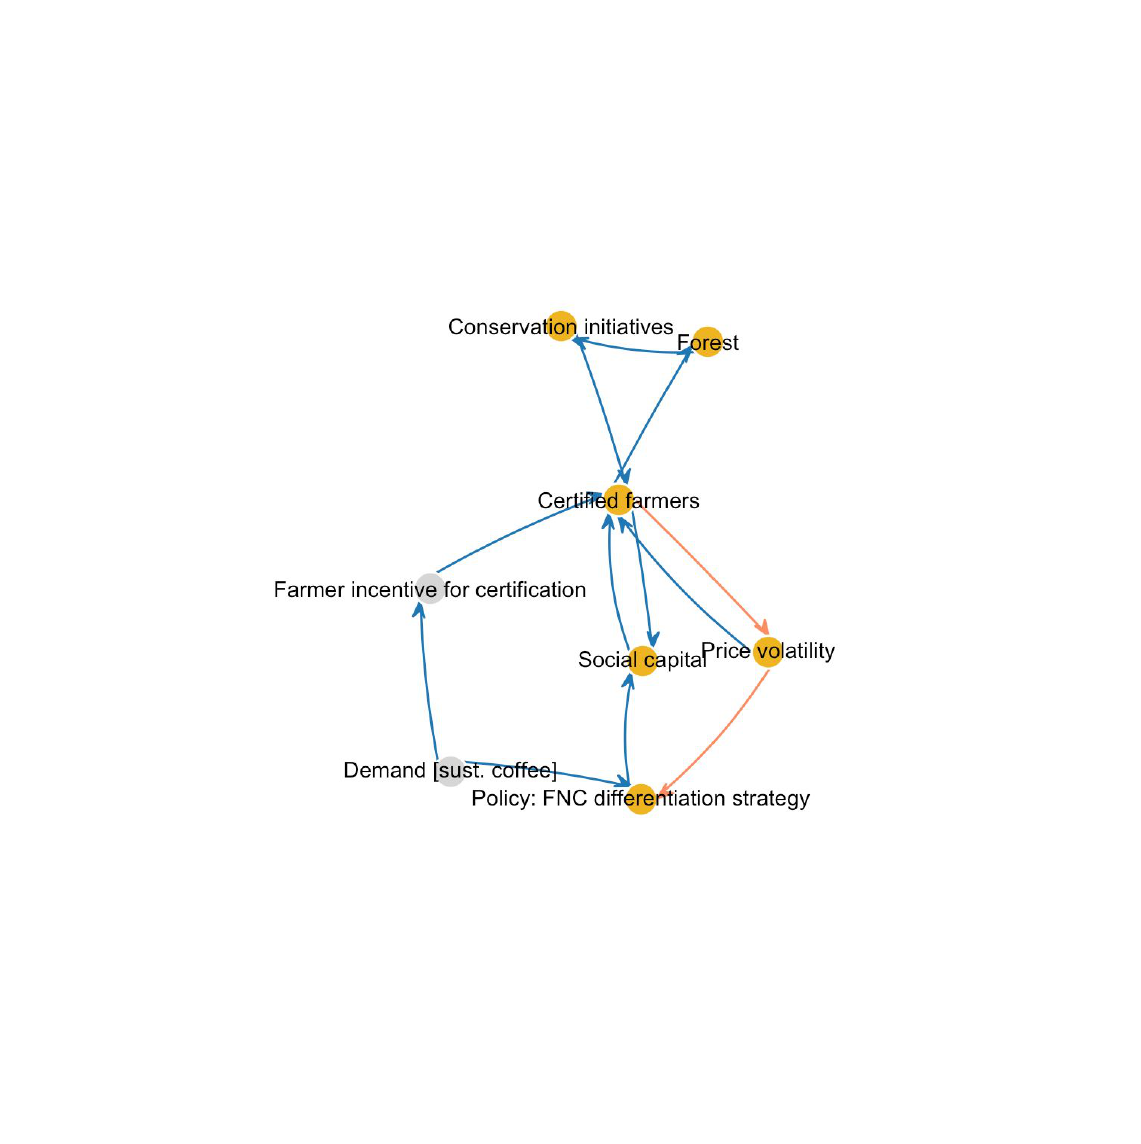
Figure A1.3. CLD eco-certification of coffee in Santander, ​​